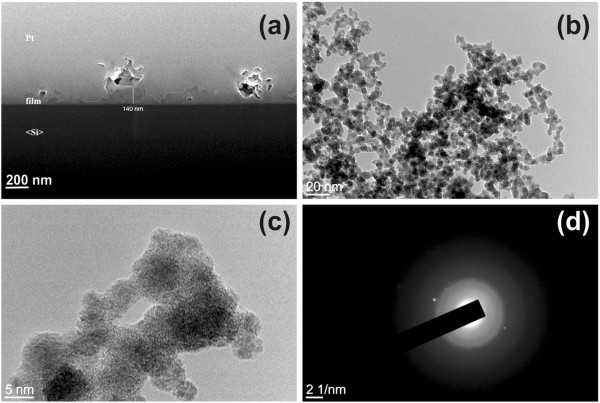
FIB and TEM images of the TaNxfilm deposited on Si. (a) Cross section of the TaNx film deposited on Si obtained with FIB technique. (b) TEM image of amorphous and chain-like structures. (c) HRTEM image of 5-nm nanoparticles forming the chain-like structure. (d) Selected-area electron diffraction (SAED) pattern, where beside the diffused broad band characteristic for amorphous material, faint spots are present which could be indexed as cubic Fm-3m tantalum.